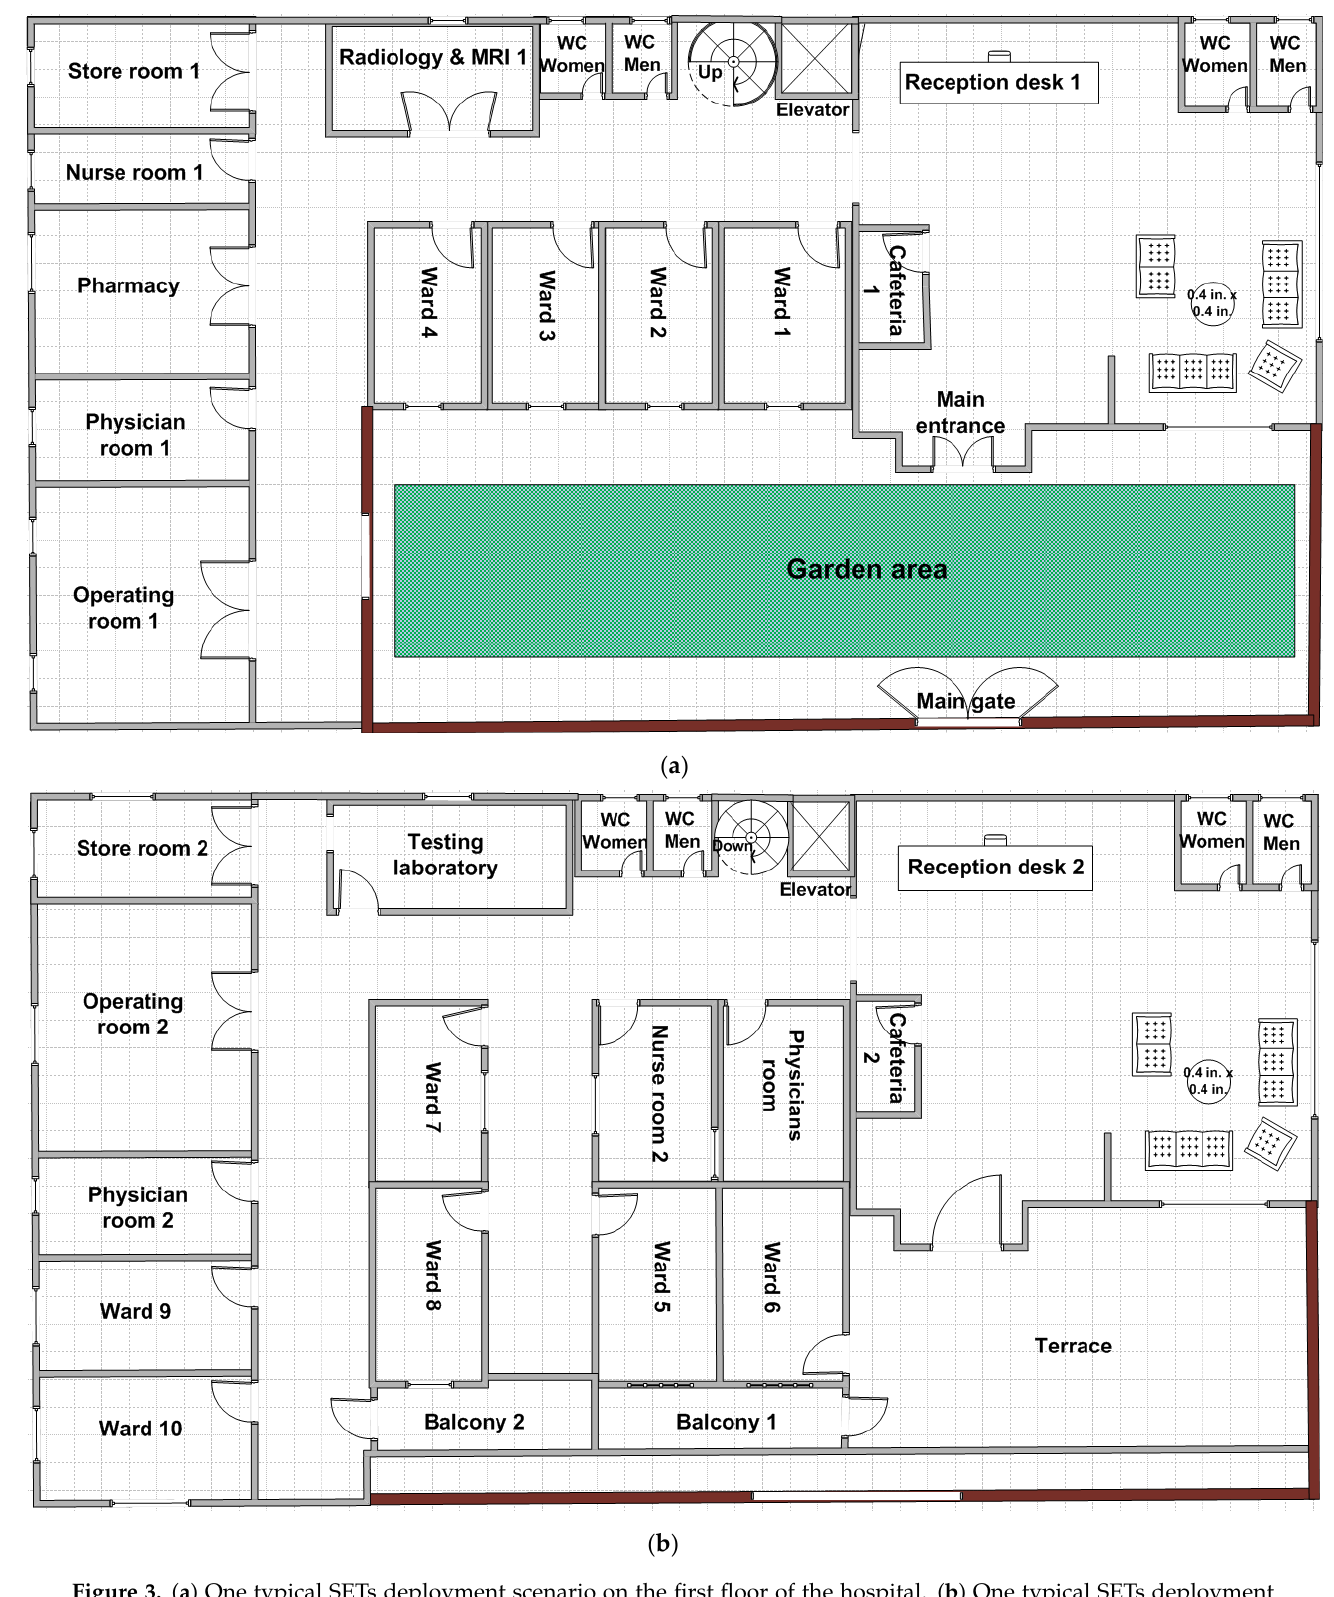
Figure 3. ( a ) One typical SETs deployment scenario on the first floor of the hospital. ( b ) One typical SETs deployment scenario on the first floor of the hospital.